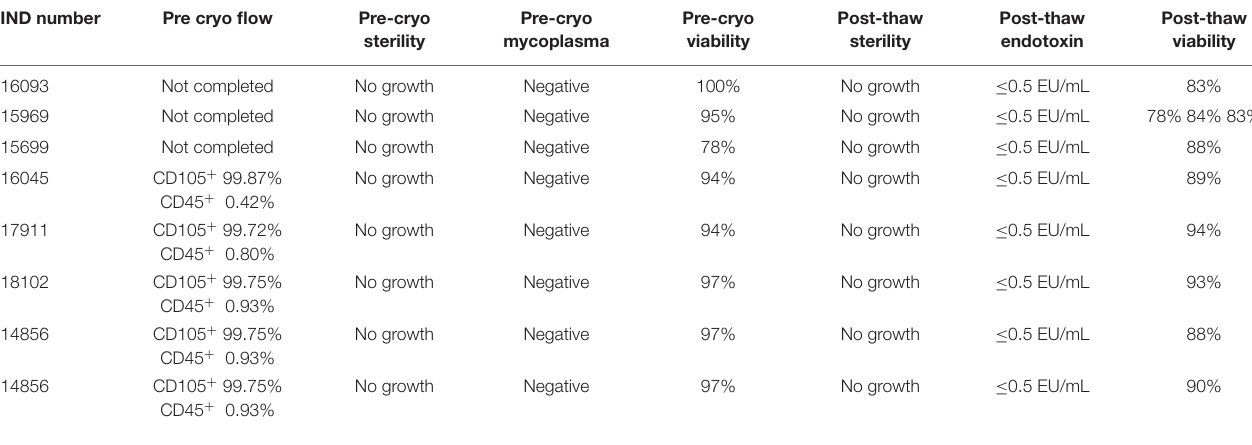
TABLE 2 | Release criteria analysis of final MSC